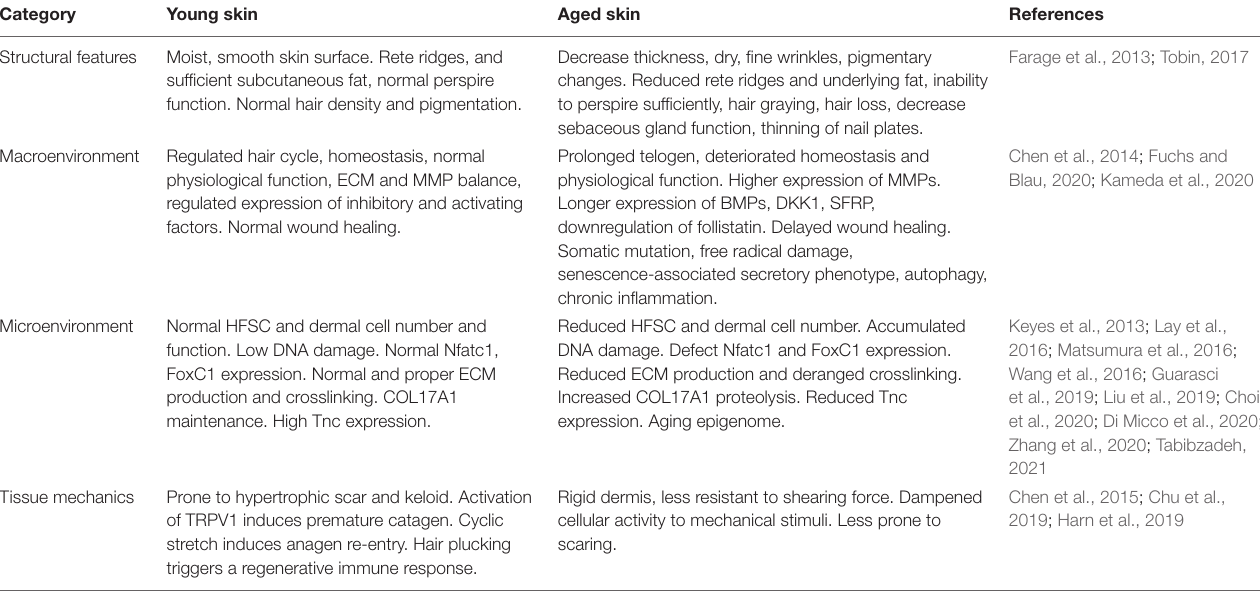
TABLE 1 | Comparison of key differences between young and aged skin. Category Young skin Aged skin Structural